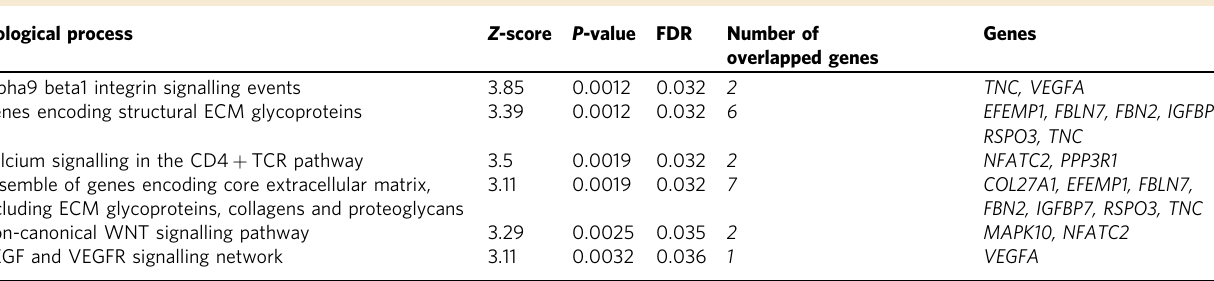
Table 1 Gene-based enrichment